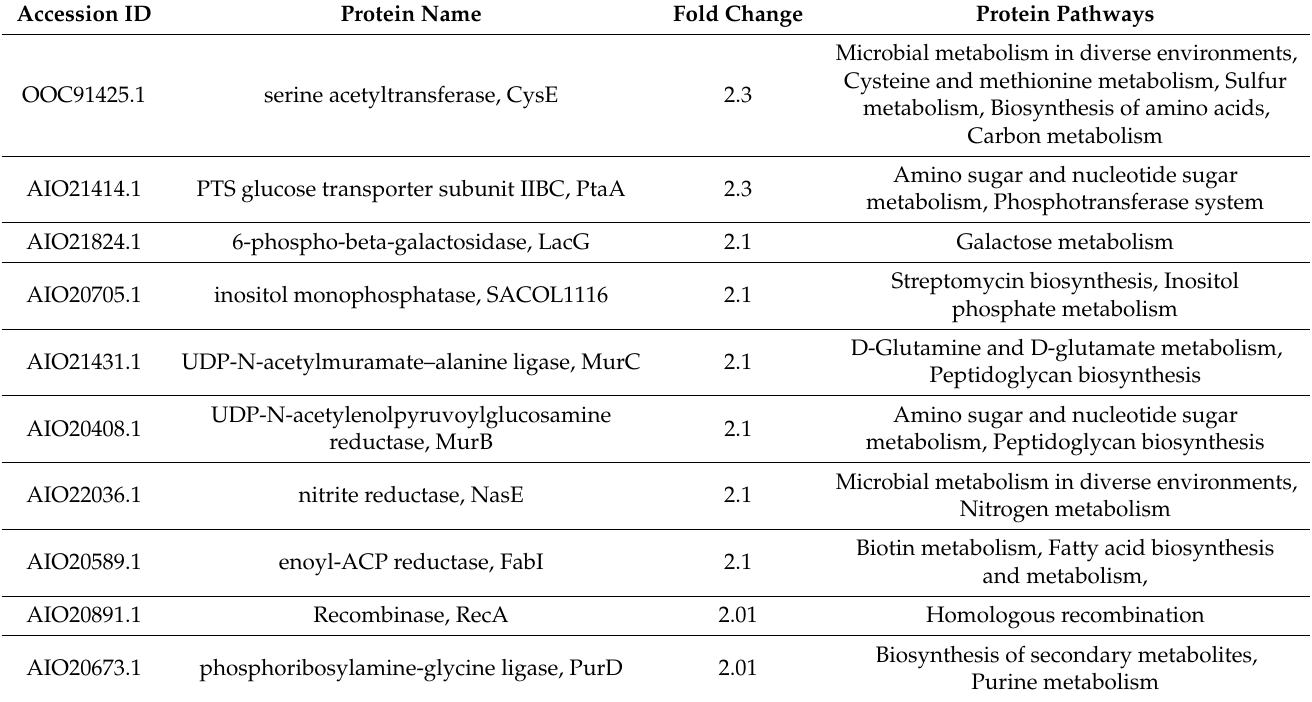
Table 2. Functional classification of the significantly upregulated proteins in DSB in comparison to hydrated biofilm ( p <